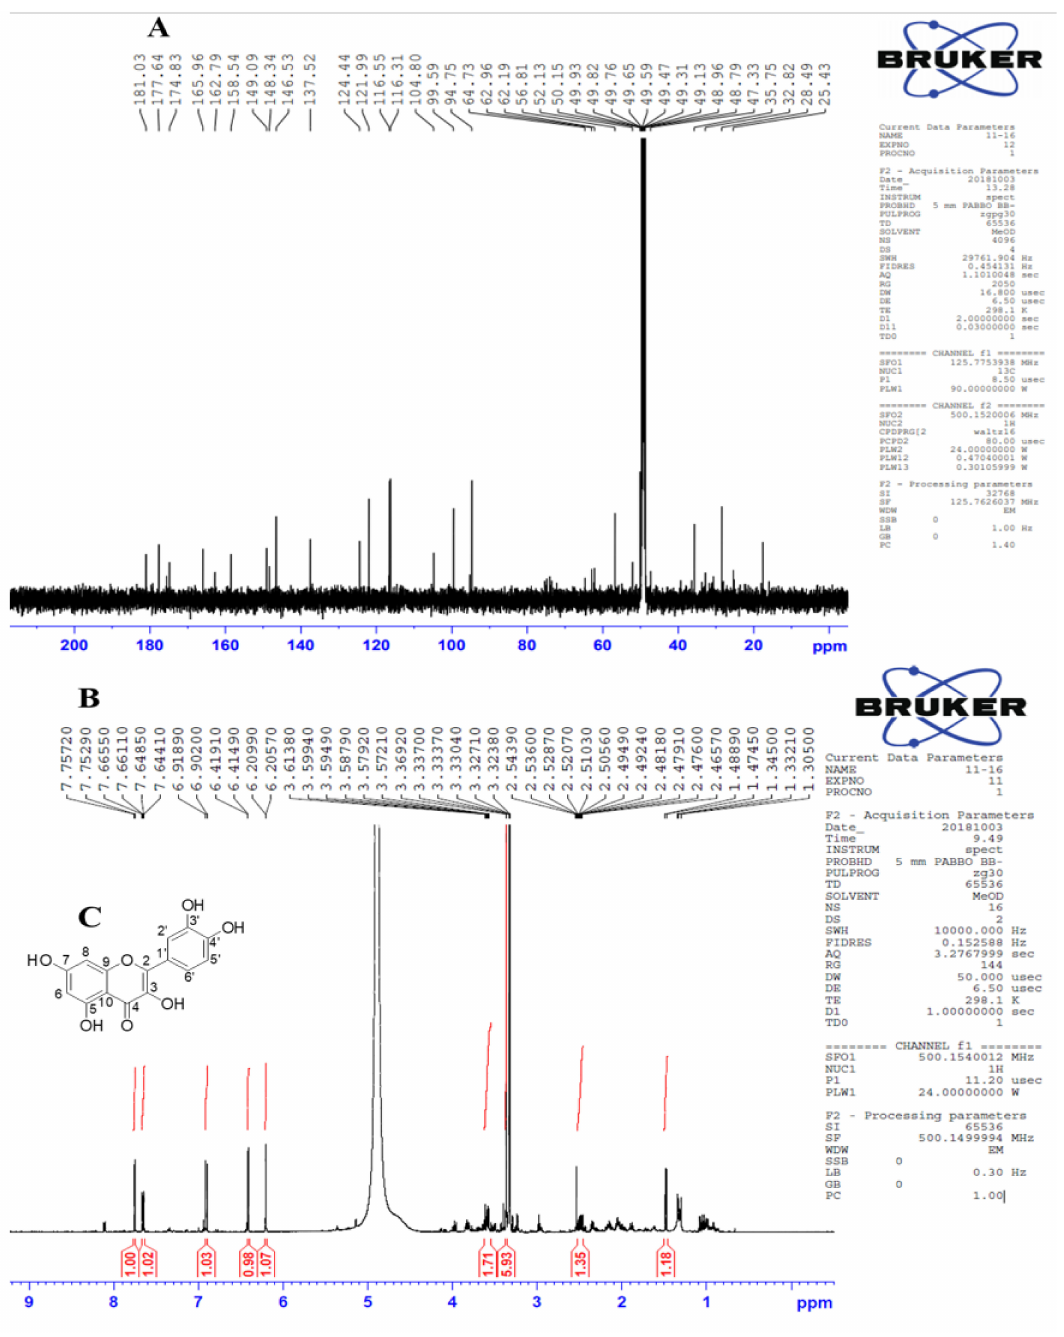
Figure 3. 13C and 1H NMR spectra ( A , B ), respectively) of quercetin. The proposed structure is shown in ( C